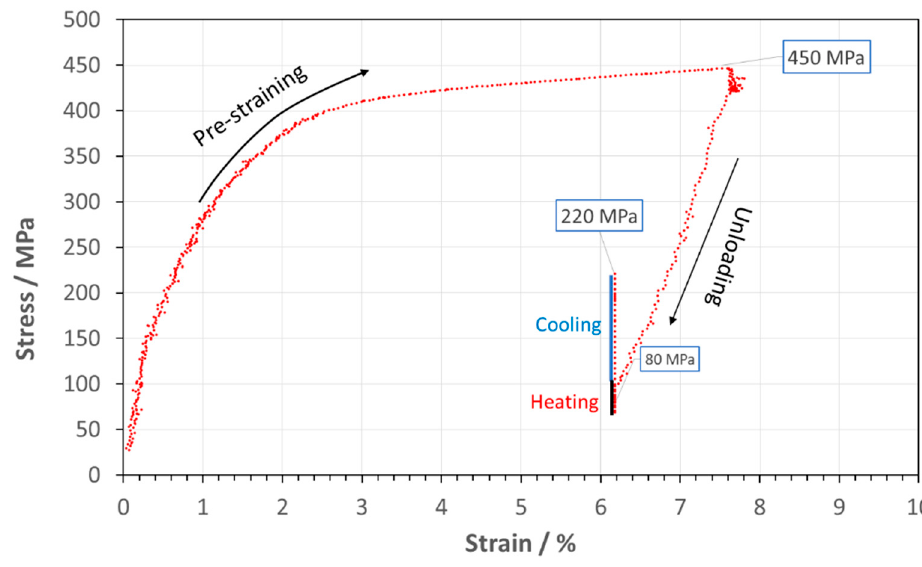
Figure 15. Stress–strain curve of the SMA alloy showing the effect of the pre-straining and the activation process.